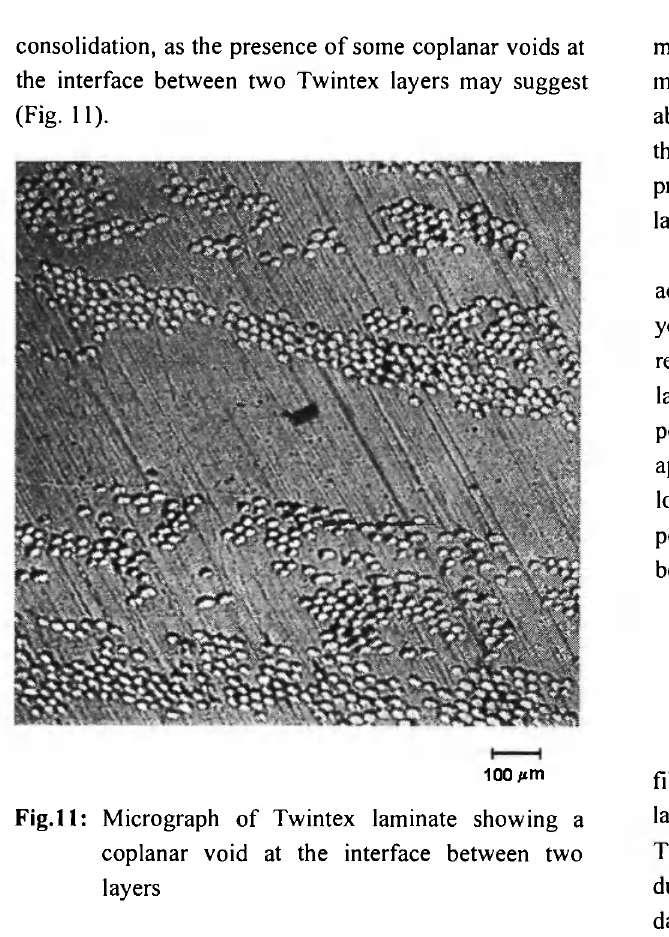
Fig.ll: Micrograph of Twintex laminate showing a coplanar void at the interface between two